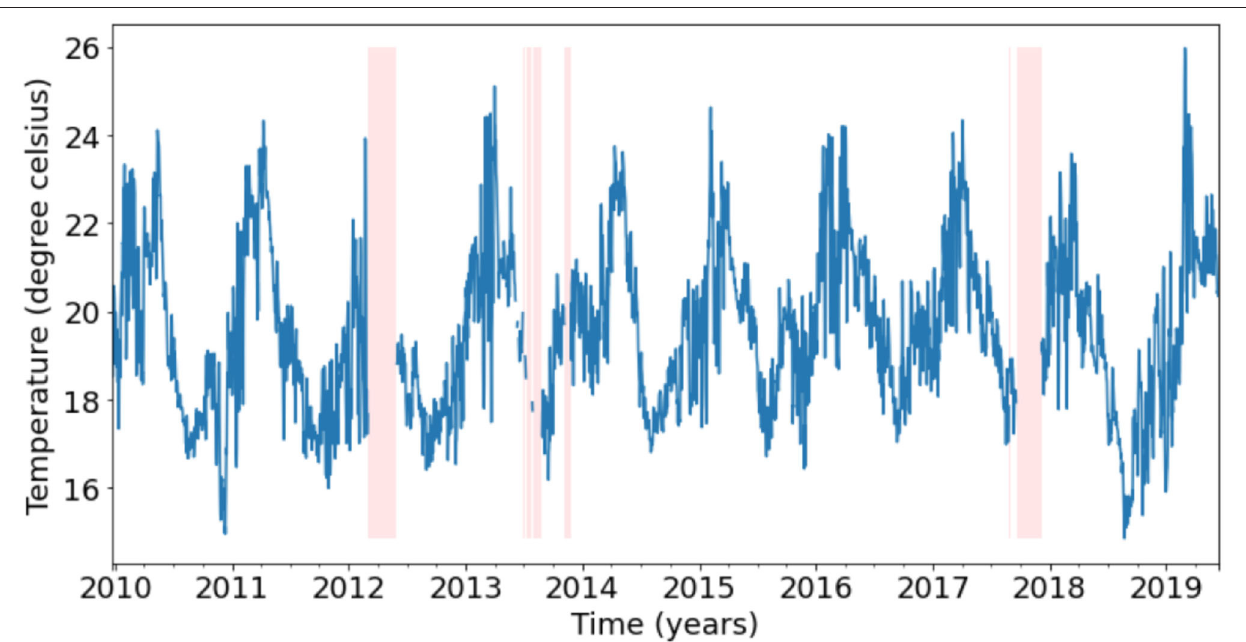
FIGURE 3 | Depiction of the 24.5m bin temperature timeseries with gaps represented by pink vertical bands. Refer to Table 1 for the lengths of the gaps.